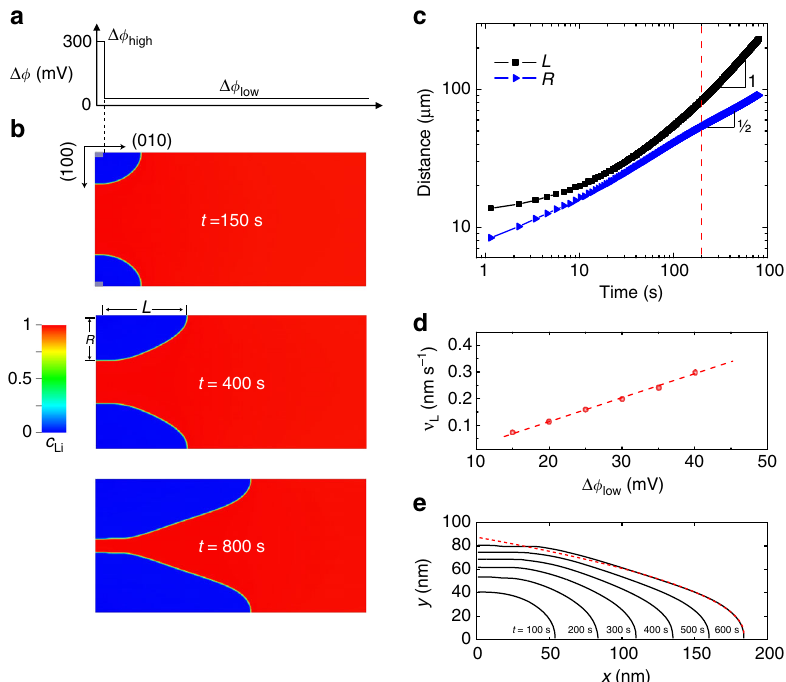
Fig. 5 Phase- fi eld simulation of delithiation in LiFePO 4 . a Illustration of stepwise overpotential applied on (100)/(001) surface. b Snapshots of FP phase morphology (blue domains) at time 150 s, 400 s, and 800 s in delithiation simulation with ϕ low = 35 mV. c Log – log plot of the dimensions of FP domain along [010] and [100]/[001], de fi ned by L and R , respectively, against delithiation time. L ( t ) and R ( t ) has a slope of 1 and ½ , respectively. d TPJ velocity (circles) obtained from phase- fi eld simulation as a function of ϕ low . The dashed line is a guide to eyes. e Time evolution of phase-boundary morphology. Phase boundary at different delithiation times exhibits steady-state morphology near TPJ (or [010] growth front), which can be described by a parabolic ffiffiffiffiffiffiffiffiffiffiffiffiffiffiffiffi L t ð Þ (cid:3) x curve (red dashed line) y ∝